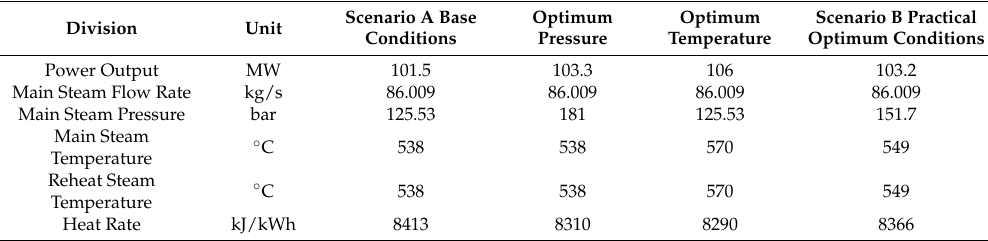
Table 3. Steam Parameters in 100 MW power plants utilizing BFGs.